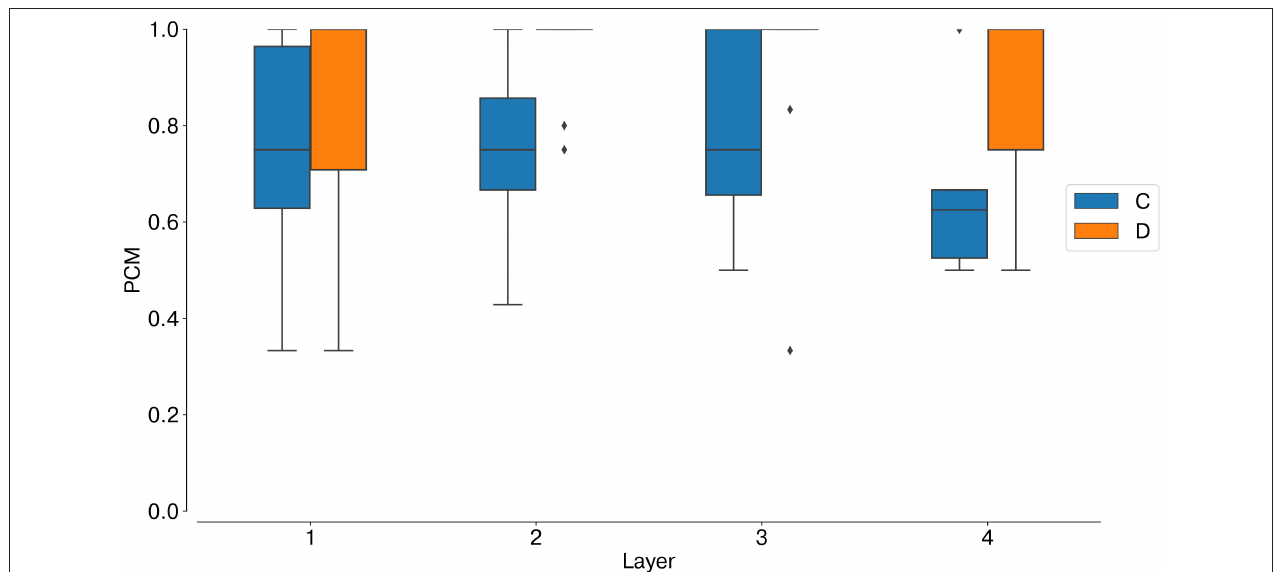
FIGURE 10 | Stereo matching accuracy: PCM, median and interquartile range. In all network layers (L1–4) the PCM of disparity neurons is larger than the PCM of coincidence neurons, showing that disparity detectors can still solve the stereo ambiguity with slower, and uncorrelated, real stimuli.